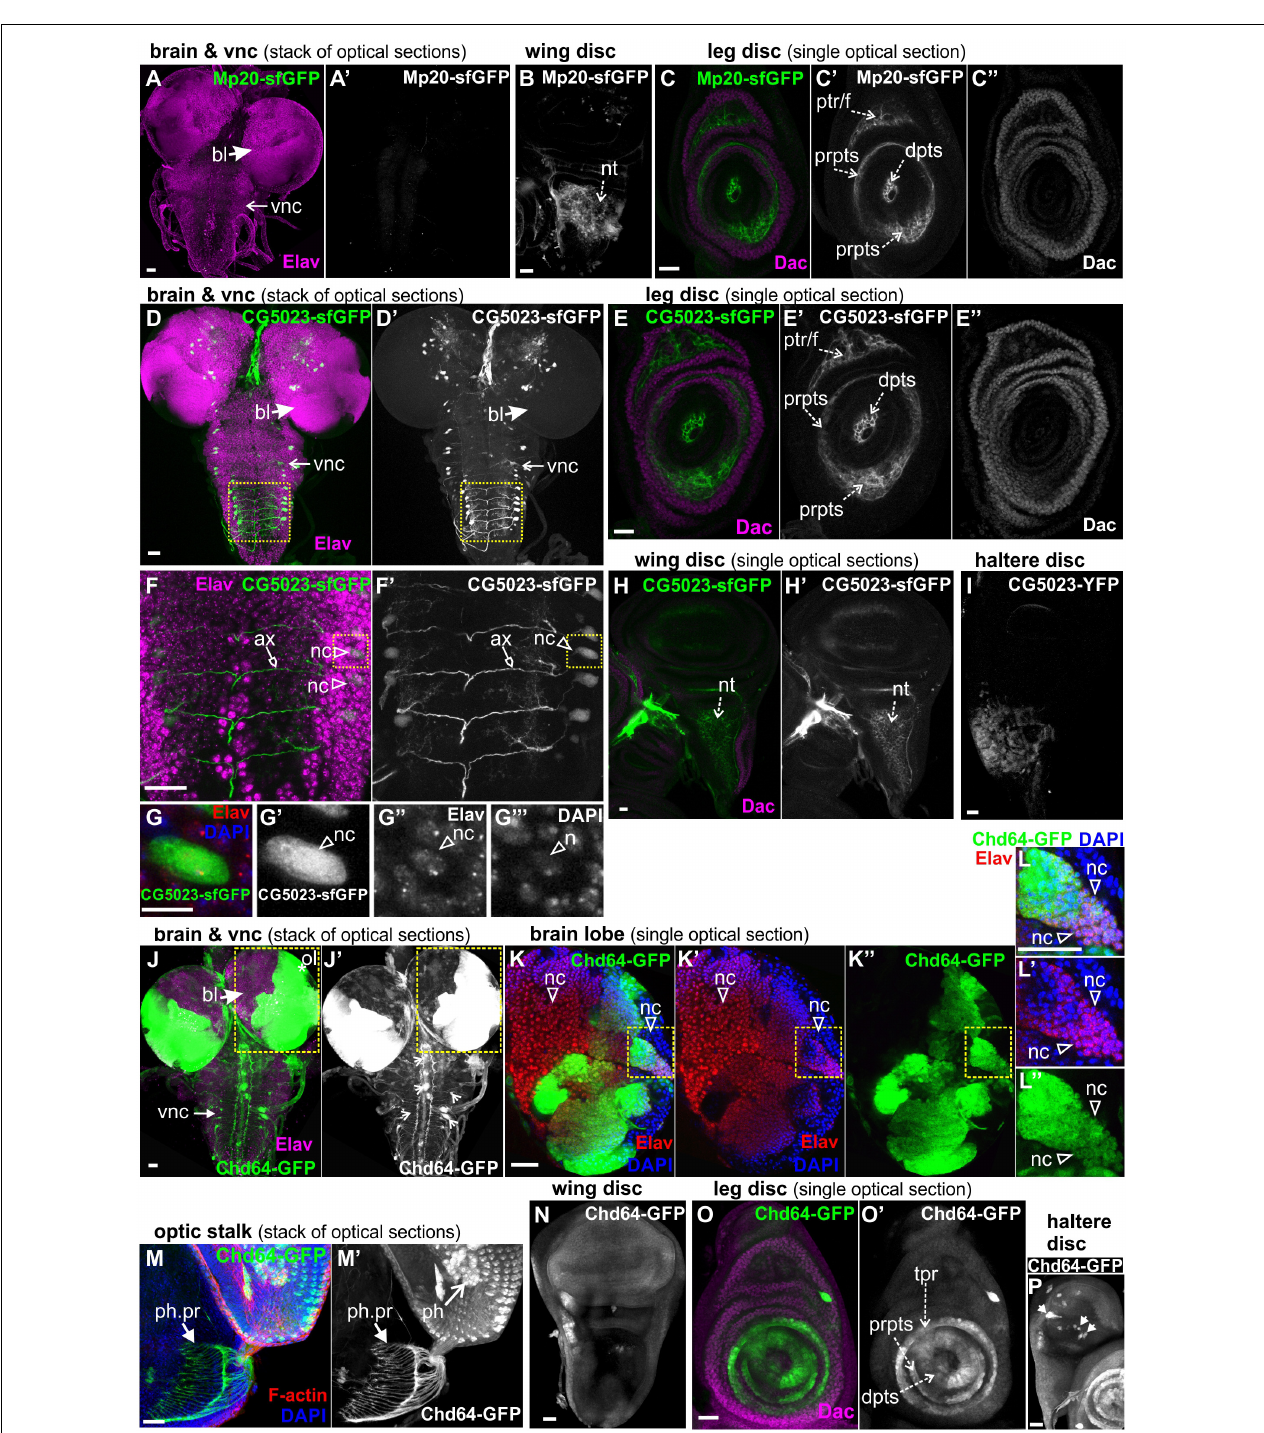
FIGURE 7 | GFP-tagged transgelin protein expression in imaginal disks derived from third-instar larvae. Confocal micrographs of dissected disks expressing fluorescently tagged transgelin proteins and probed with various antibodies to label specific disk markers. (A–C) Mp20-sfGFP expression pattern. (A) Mp20-sfGFP is not expressed in the larval brain or ventral nerve cord, which both are labeled with Elav. (B,C) Single optical sections of the imaged disks. (B) Mp20-sfGFP is expressed in the wing disk notum region. (C) Mp20-sfGFP is expressed in specific regions of leg disks. Mp20-sfGFP is partially colocalized with Dachshund (Dac) in the progenitor’s area of trochanter and femur, but is additionally expressed in the distal tarsal segments, where Dac is not expressed. (D–G) CG5023-sfGFP protein expression pattern. (D,D (cid:48) ,F,F (cid:48) ,G–G (cid:48)(cid:48)(cid:48) ) CG5023-sfGFP is expressed in certain neuronal cells both in the brain lobes and the ventral nerve cord (vnc), which both are labeled with Elav. (F,F (cid:48) ) High-magnification image of the boxed region in panels (D,D (cid:48) ) , where it clearly shows the coexpression of CG5023-sfGFP and Elav in the